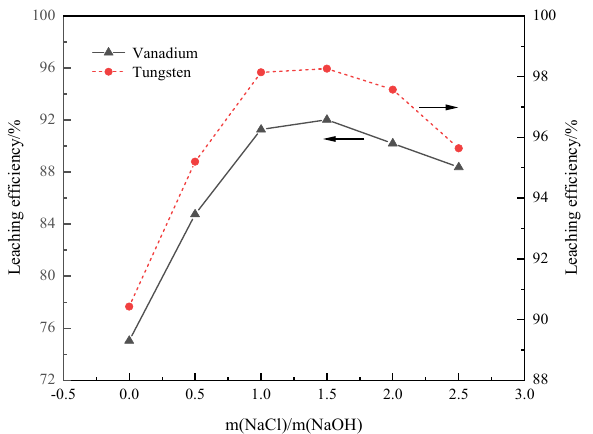
Figure 7. The effect of the mass ratio of NaCl and NaOH on the leaching efficiencies of V and